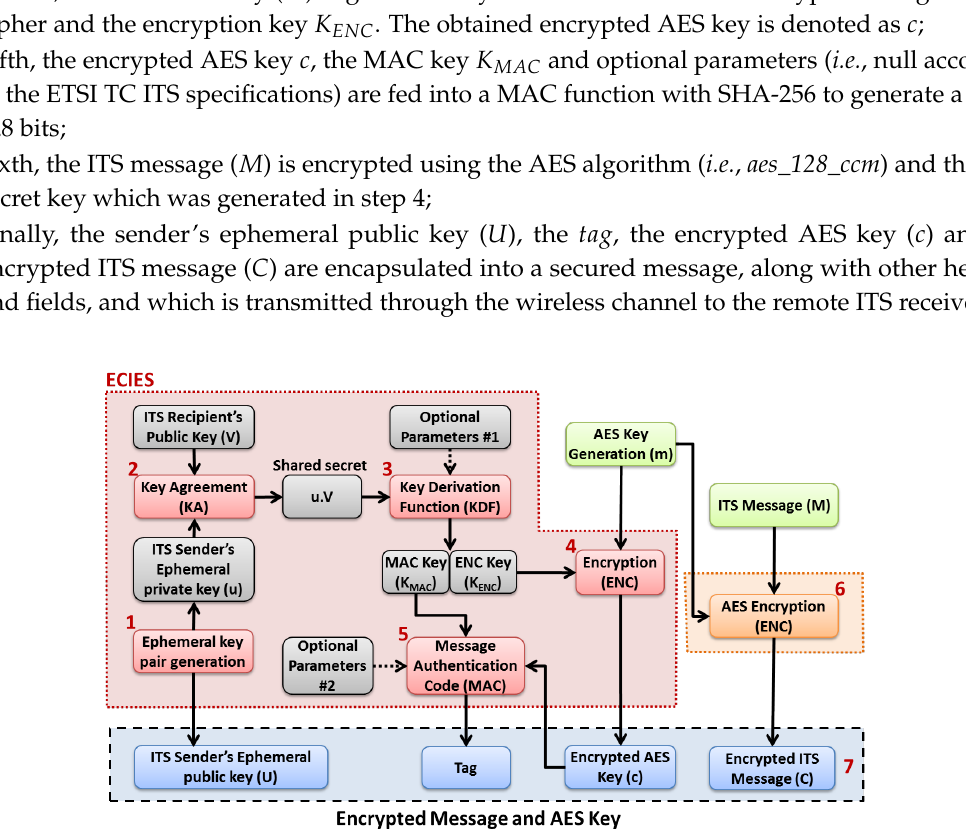
Figure 7. ECIES with AES based message encryption